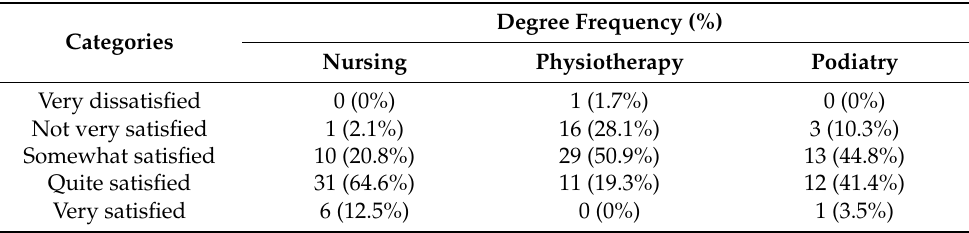
Table 5. Results of the degree of satisfaction with the supervision of placements depending on the